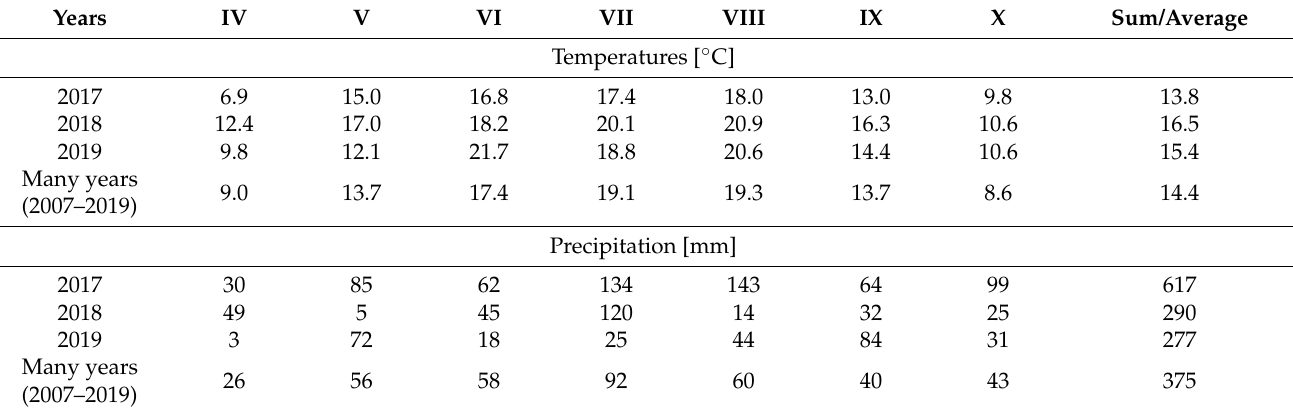
Table 3. Thermal and precipitation conditions during maize growing seasons adapted from